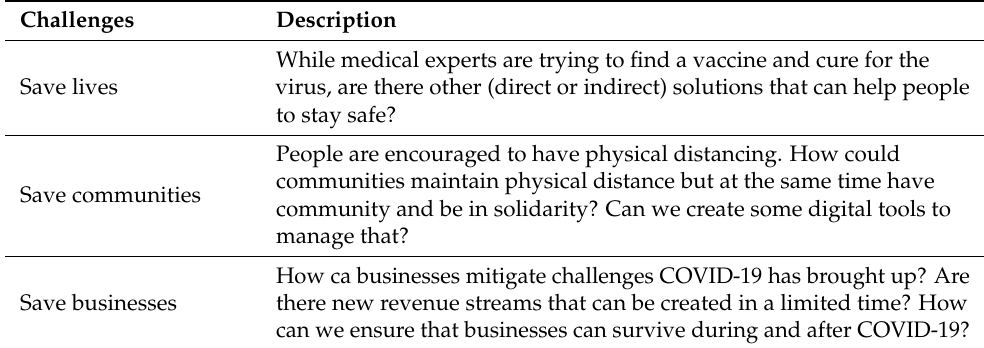
Table 3. Challenges at